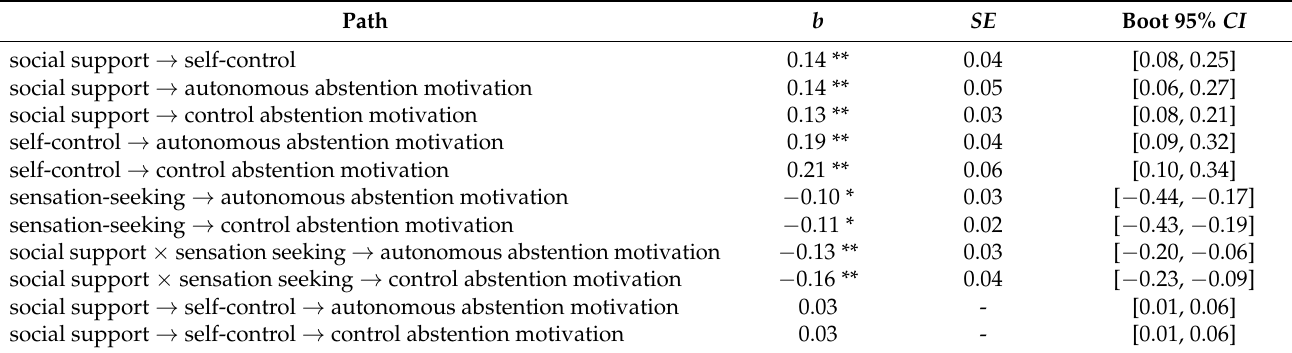
Table 2. The regression models of all